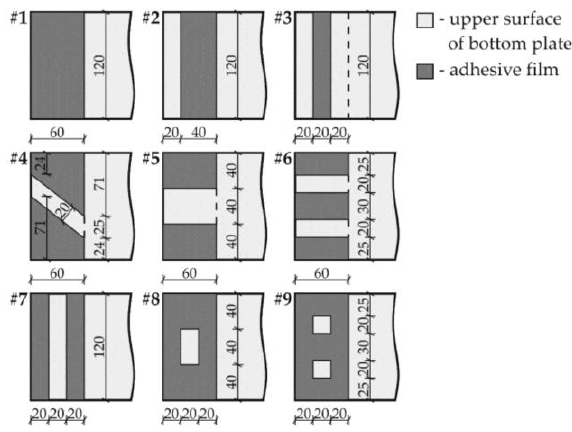
Figure 2. Investigated specimens: intact (#1) and with defects